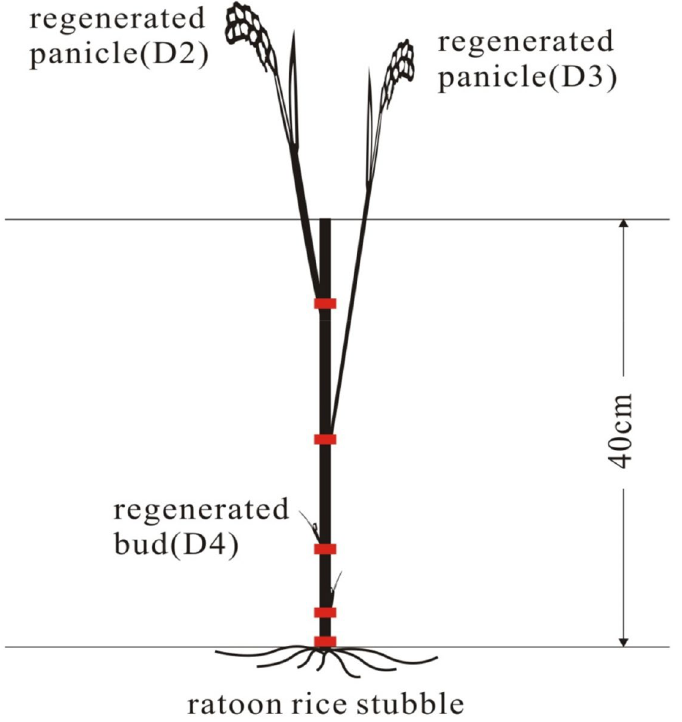
Figure 1. The brief diagram of the nodes, regenerated panicles and regenerated buds in ratoon rice system. D2, D3 and D4 represent the second node from top, third node from the top, and other nodes below the third node from main crop